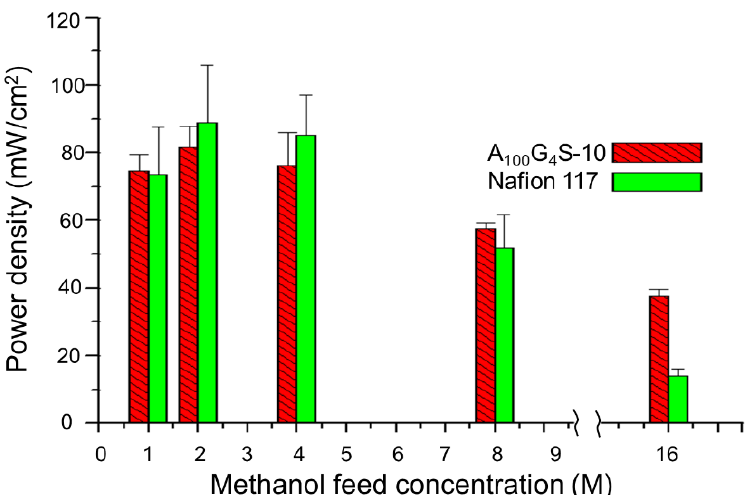
Figure 13. Maximum power density with different methanol feed concentrations at 50 °C. All tests were carried out after conditioning the cell for 30 min at the open-circuit condition (flow rate: 5 cc/min for MeOH and 50 cc/min for dry oxygen).